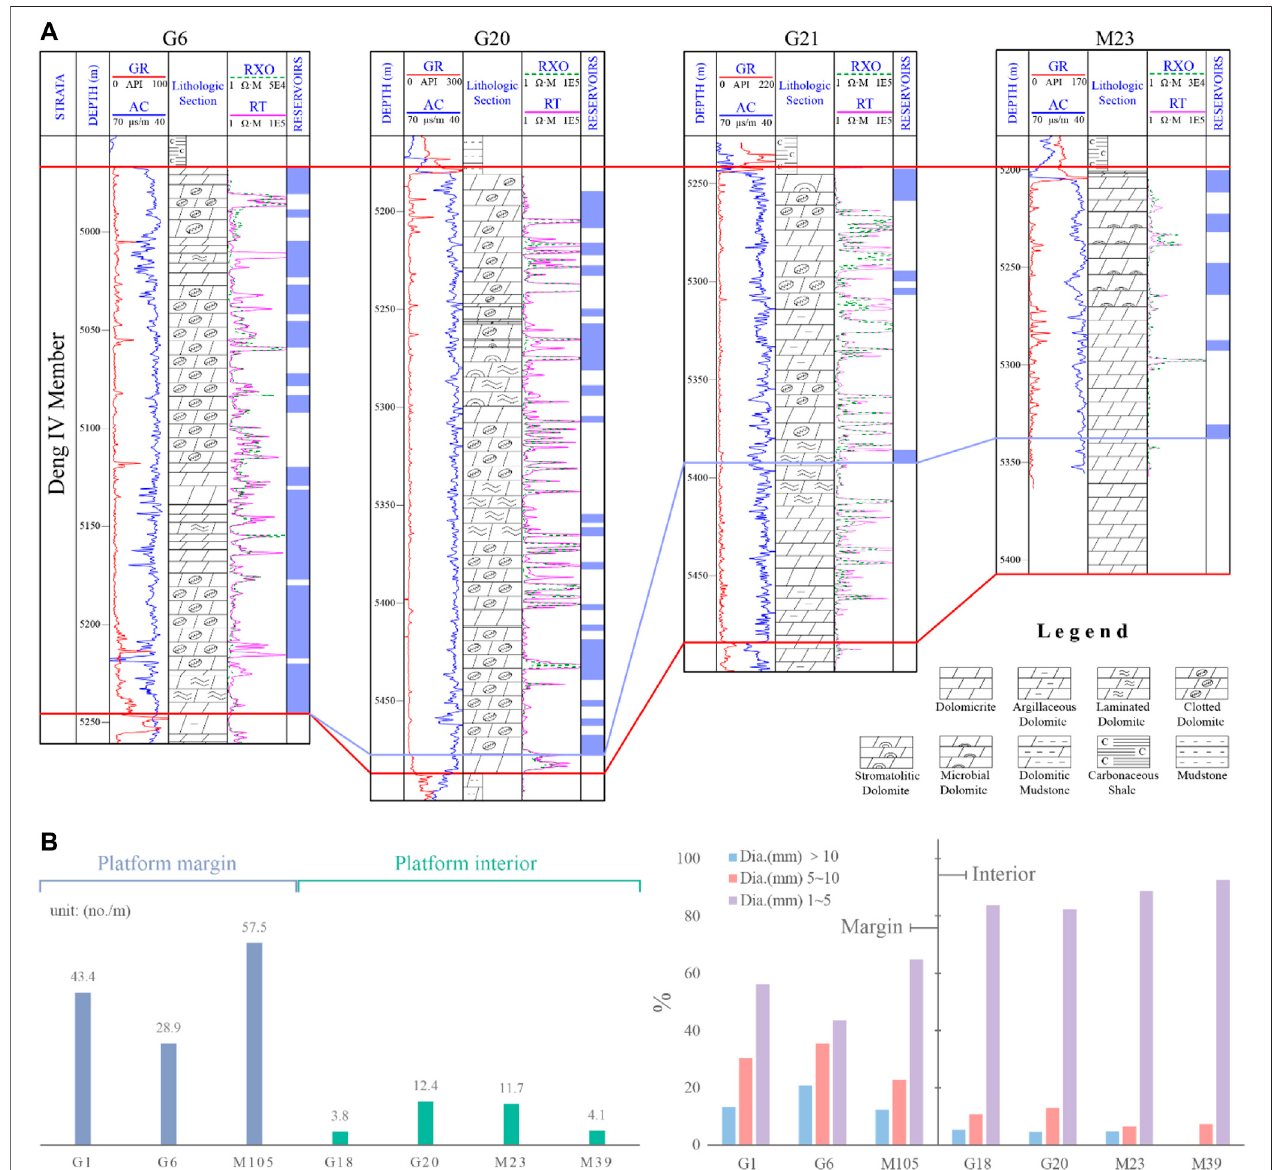
FIGURE 9 | (A) multi-borewell correlation of reservoirs of Z 2 dn 4 . The reservoirs and non-reservoirs are compartmentalized by 2% porosity and 0.002 mD permeability. Note that the platform margin with more protected lithofacies greatly in fl uenced karsti fi cation. Vertical differences in the distribution and development of reservoirs may relate to karst differentiation in pattern and depth. The violet-blue polyline implies the possible lower bound of karsti fi cation. For section location, see Figure 6A . (B) statistic differences in number and diameter of vugs between the platform margin and interior (data cited from Tian et al. (2020)).